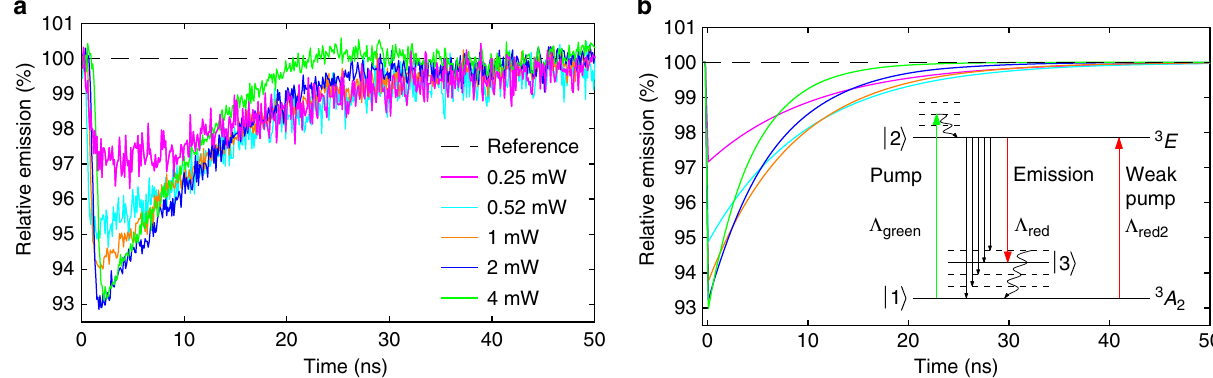
Figure 4 | Emission reduction and recovery for different green CW powers. ( a ) Experimental data where the red pulse was at t E 1ns. The recovery rate increases with increasing green power. The time-averaged red power was measured as 1.73mW. ( b ) The theoretical modelling, reproducing a . NATURE COMMUNICATIONS|8:14000|DOI: